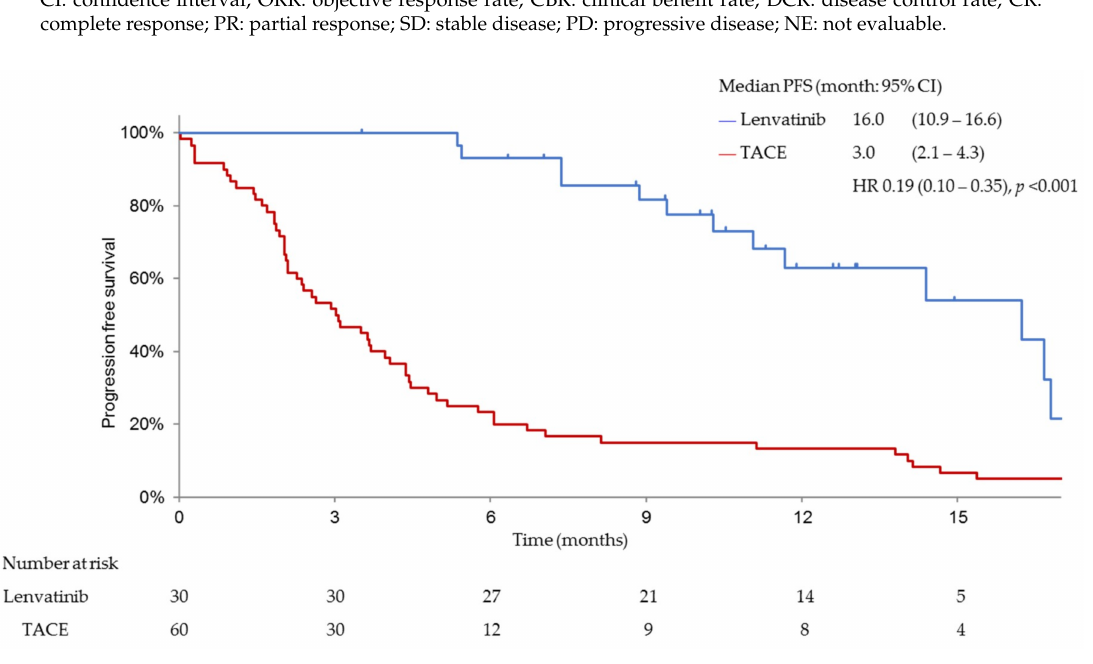
Figure 3. Progression free survival (PFS) in both groups with Child–Pugh A liver function after propensity score matching. PFS in the lenvatinib-treated group was significantly better than that in the